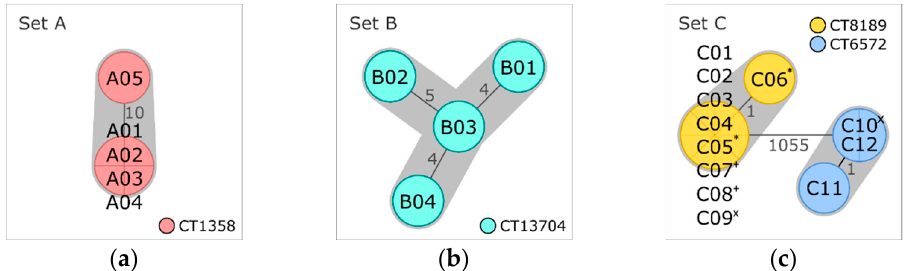
Figure 2. Minimum spanning trees based on core genome multilocus sequence typing (cgMLST) of ( a ) set A isolates obtained from the same meat sample, ( b ) set B isolates obtained from another meat sample, and ( c ) set C isolates obtained from processing plant 1. Isolates are represented in circles, which are colored according to their cgMLST type (CT). The number of allelic distances are shown next to the lines connecting the respective isolates. Clusters with allele difference ≤ 10 are shaded in gray. Superscripts mark set C isolates that were obtained from the same sample (* sample 7, + sample 8, and x sample 9).